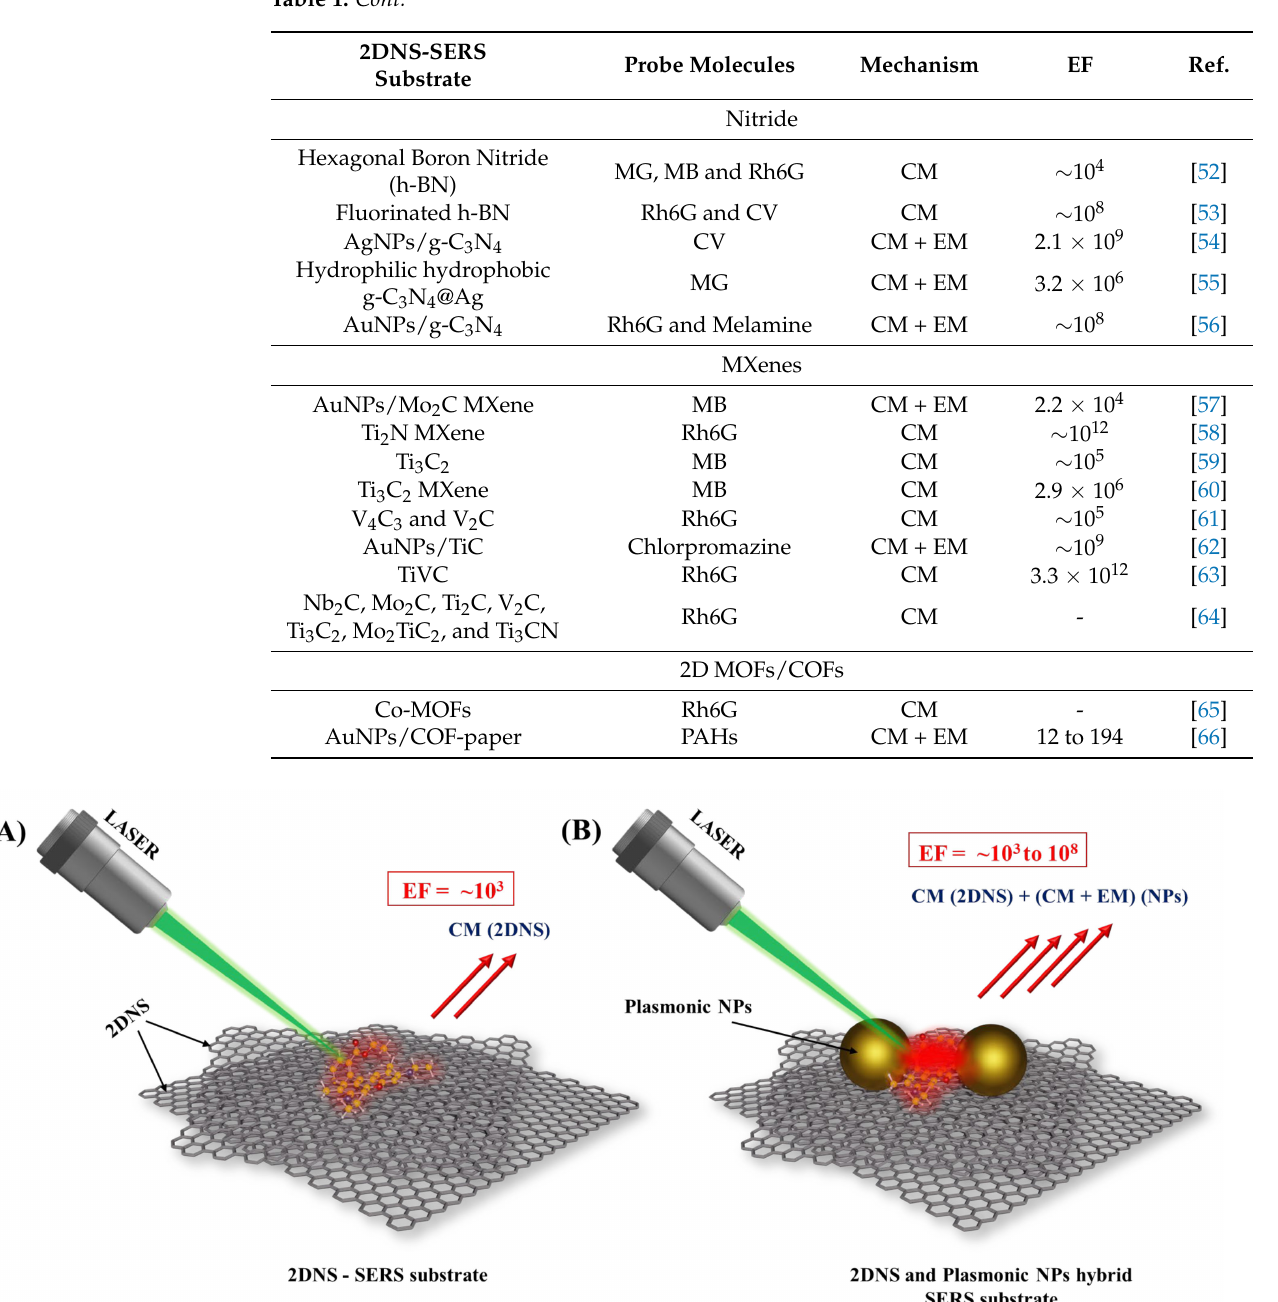
Figure 2. Schematic illustration of ( A ) 2DNS SERS substrate rendering enhancement through CM and ( B ) 2DNS as support for plasmonic NPs SERS substrate that enhances Raman signal by both CM (from 2DNS and NPs) and EM (from